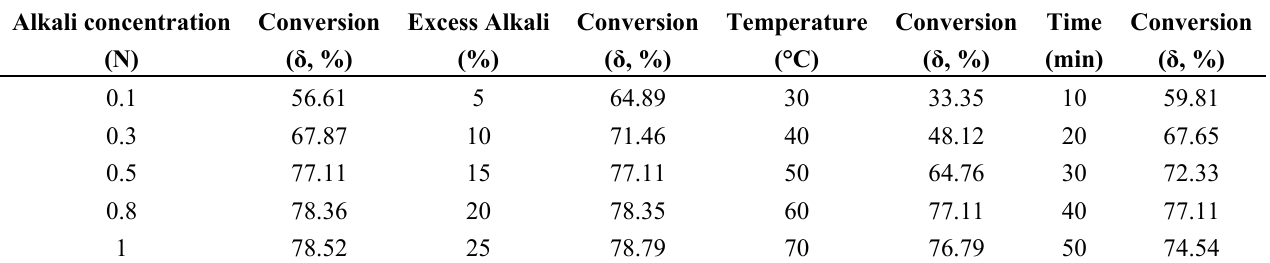
Table 1. Effect of alkali concentration, excess alkali, temperature and time on the deacidification. Alkali